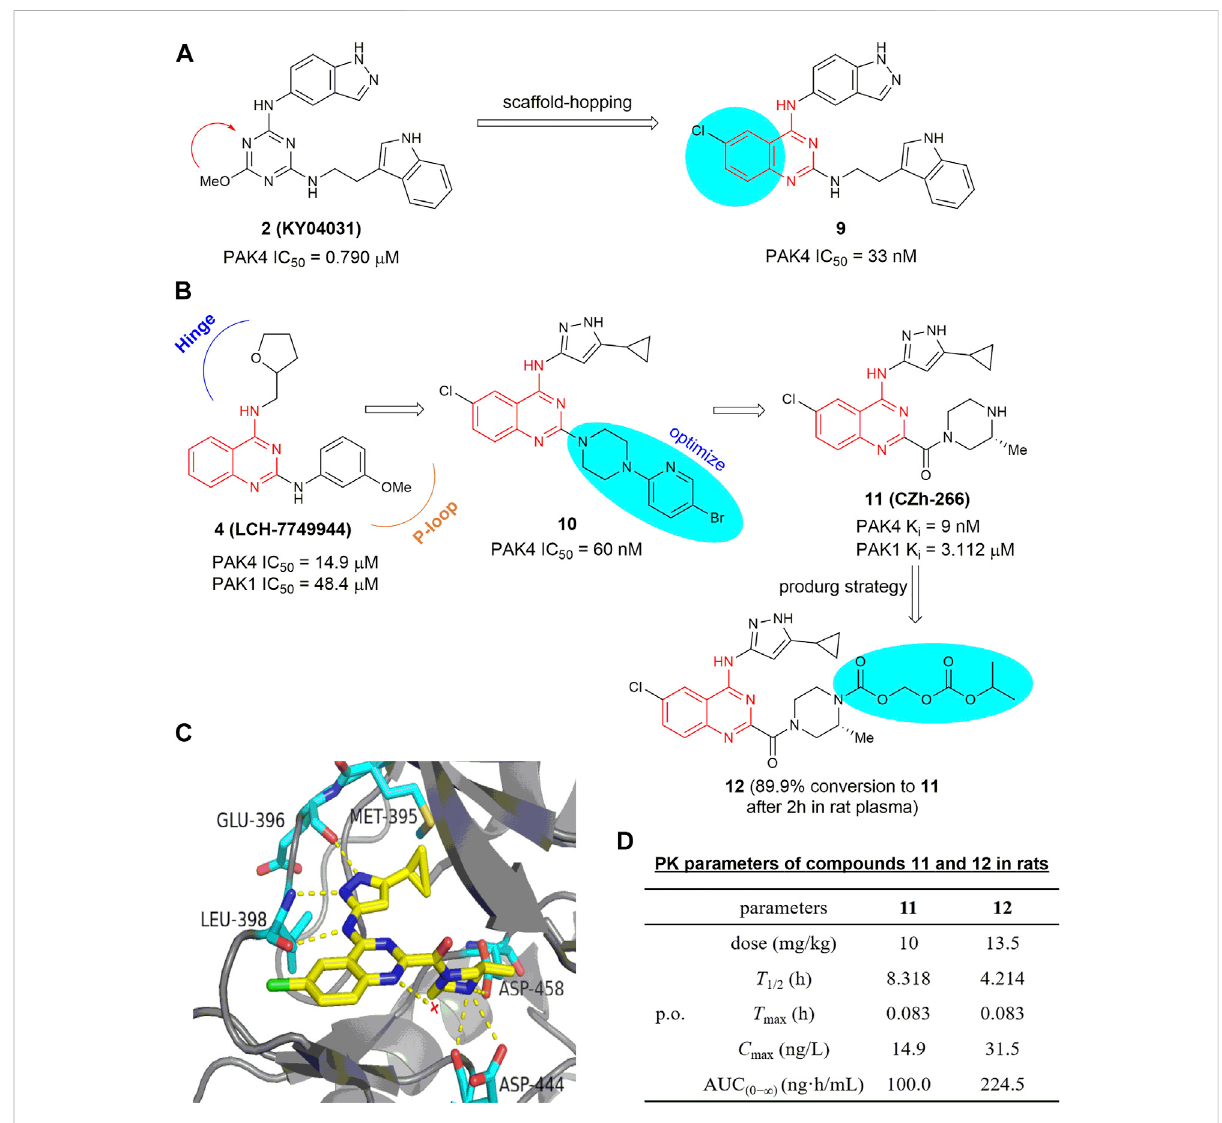
FIGURE 7 (A) Designofcompound9. (B) The optimizationprocess leading tocompounds10 and11. (C) The crystal structureofcompound